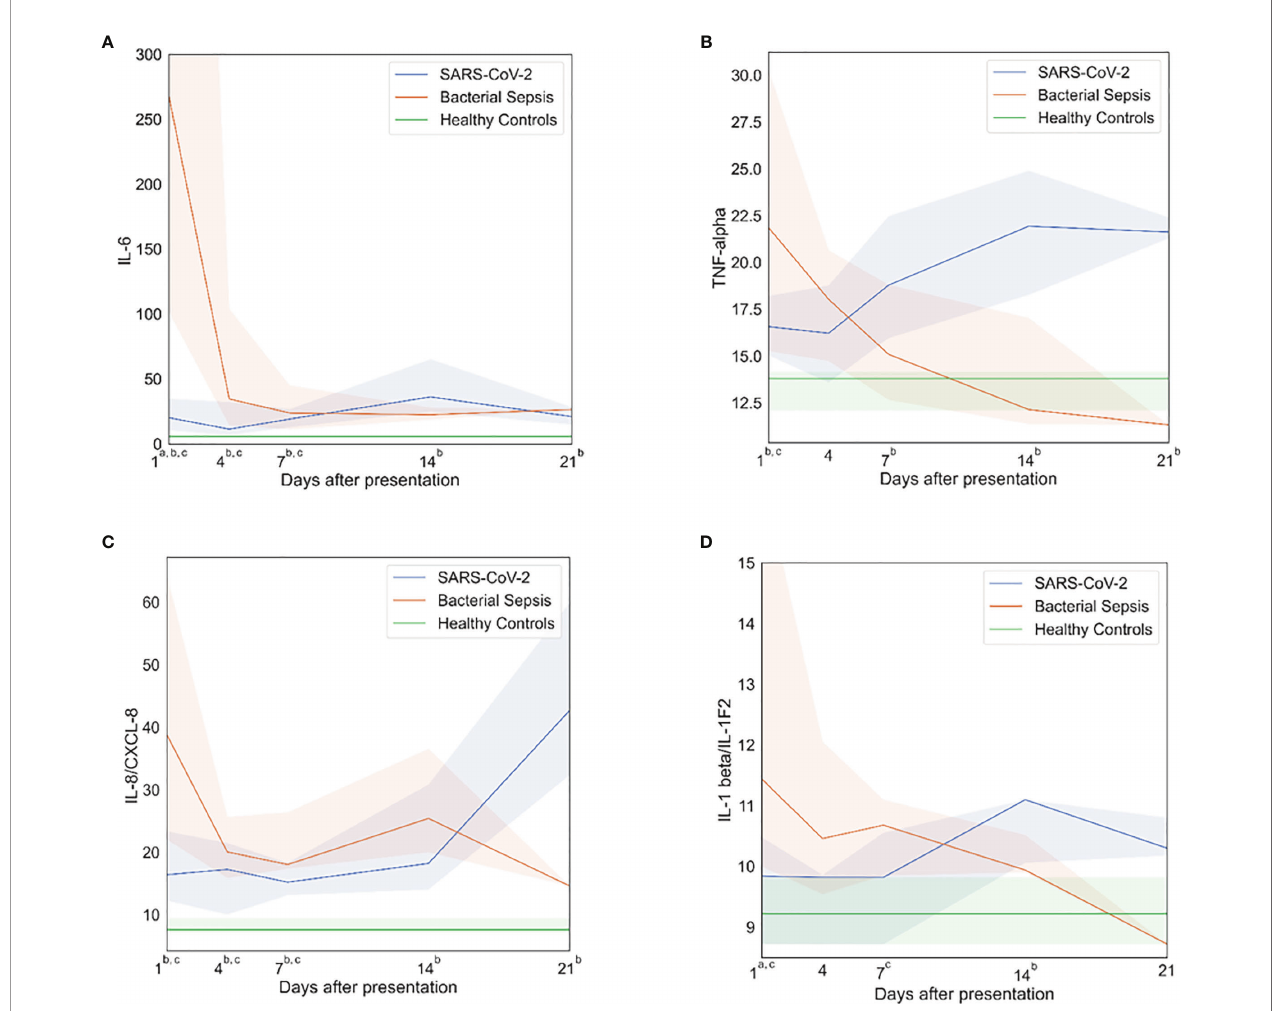
FIGURE 1 | In fl ammatory pro fi les. After bacterial sepsis, in fl ammatory cytokines peaked on sampling day one and then declined; after SARS-CoV-2 infection, in fl ammatory cytokines were persistently elevated or increased over time. (A) Interleukin (IL)-6 levels over time. (B) Tumor necrosis factor (TNF)-alpha levels over time. (C) IL-8 levels over time. (D) IL-1 beta levels over time. Data are presented as median values (colored lines) and interquartile ranges (shaded regions). Groups were compared by generalized estimating equations with p-values corrected for multiple comparisons by the Benjamini-Hochberg procedure. At each time point, all available values (as listed in Supplemental Table 2 ) were included in all statistical tests for 30 SARS-CoV-2 patients, 10 bacterial sepsis patients, and 10 healthy control patients. Superscript letters indicate time points at which group comparisons had p ≤ 0.05. a SARS-CoV-2 vs. Bacterial Sepsis; b SARS-CoV-2 vs. Healthy Controls; c Bacterial Sepsis vs. Healthy